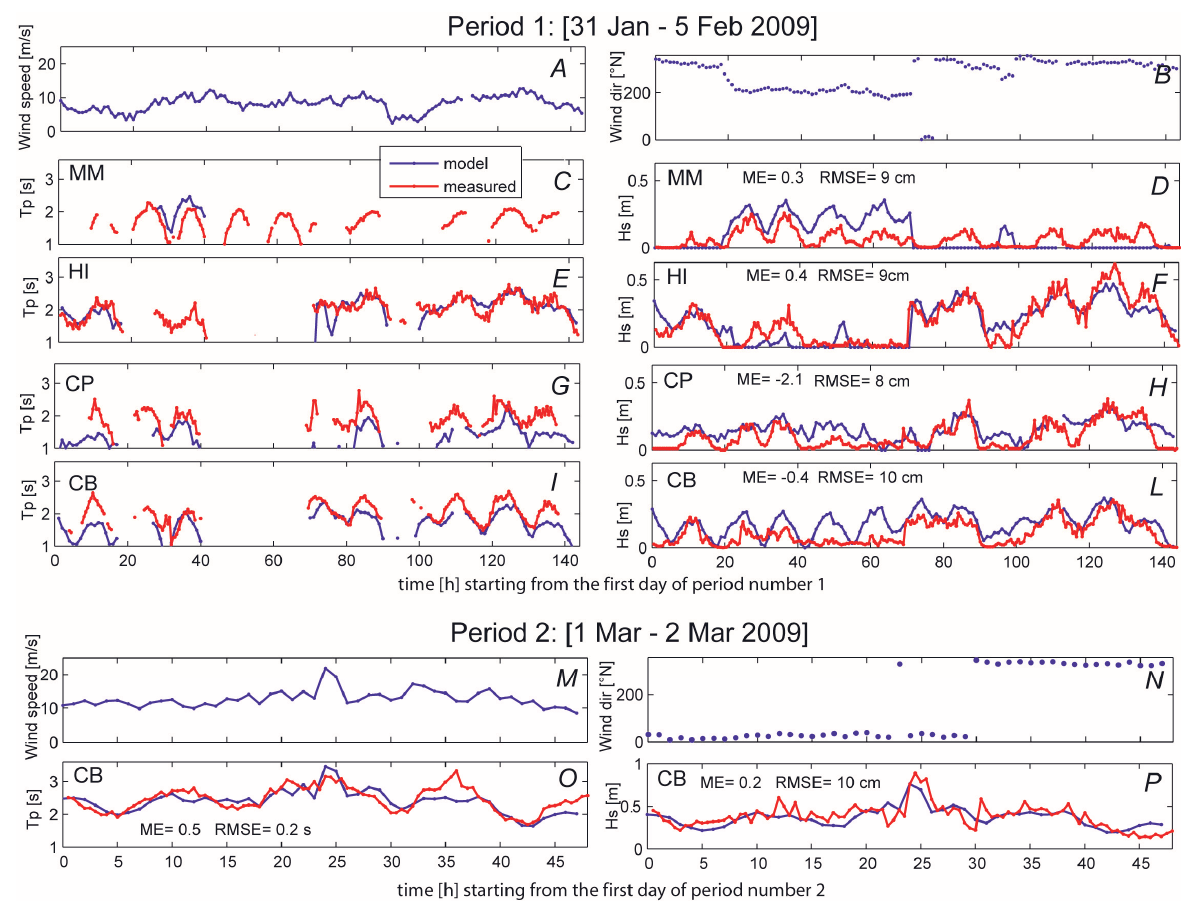
Figure 5. Model simulations of significant wave height and wave period validated against measured data for the three study sites. Wind data from NOAA Wachapreague station 8631044; ( A ) wind speed and ( B ) wind direction for period 1. Wave period for ( C ) Matulakin Marsh; ( E ) Hog Island Marsh; ( G ) Chimney Pole; ( I ) Central Bay. Wave height for ( D ) Matulakin Marsh; ( F ) Hog Island Marsh; ( H ) Chimney Pole; ( L ) Central Bay. ( M ) wind speed and ( N ) wind direction for period 2; ( O ) Wave period for Central Bay; ( P ) wave height for Central